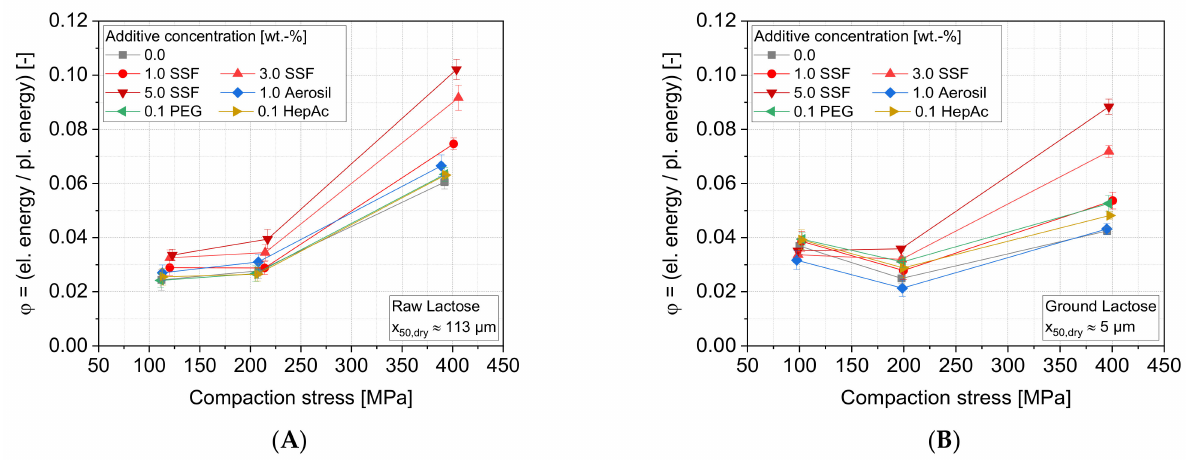
Figure 12. Ratio of elastic to plastic energy, ϕ , as a function of the compaction stress for different additives: ( A ) raw lactose and ( B ) ground lactose, n =